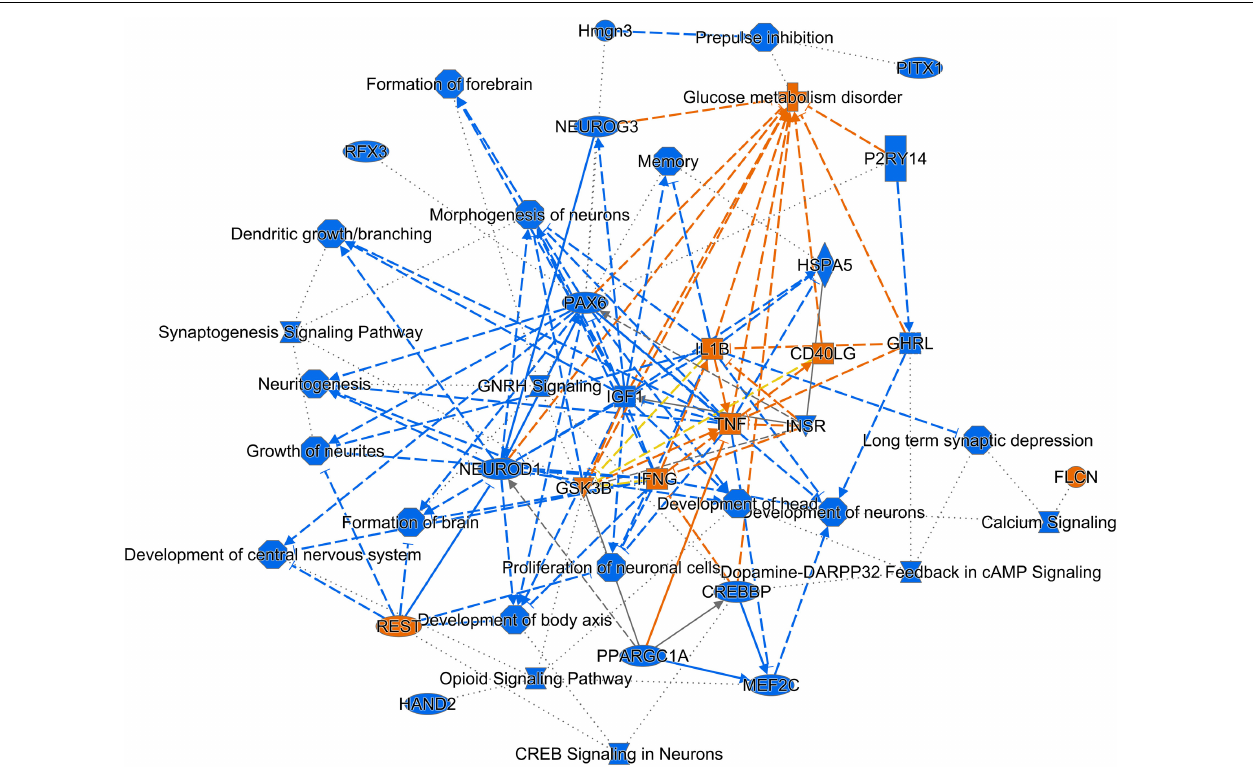
FIGURE 6 | Graphical representation of IPA analysis of up- and down-regulated genes and processes. Using IPA core analysis of down-regulated genes and processes (blue) predicted up-regulation of genes and processes (orange). There is an overall down-regulation of pathways related to synaptogenesis, development of neurons and excitatory signaling. TNF α is a key factor that influences multiple processes and genes.